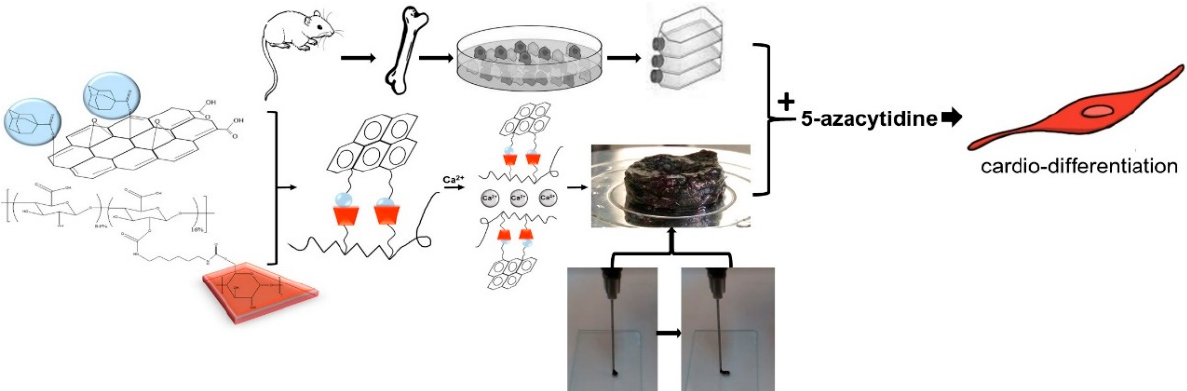
Figure 7. The schematic shows the differentiation of rMSCs to cardiac myocytes on injectable shear- thinning Alg-GO hydrogel (with GH and DC interactions) scaffolds.